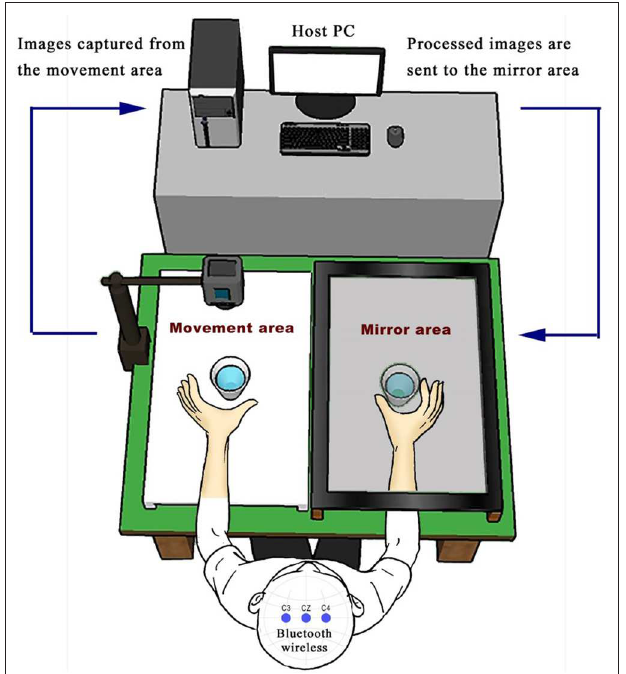
FIGURE 1 | Experimental set up: The DMT system consists of a host personal computer, camera, and therapy table with a movement area and a mirror area. The participant sits behind the table and places a paper cup for task-based training on the mirror area and their non-impaired hand (active hand) on the movement area. In the mirror area of the table, a slim, 27-inch liquid crystal display monitor was situated slightly above the table to reserve the underlying space for the impaired hand as the non-active hand.